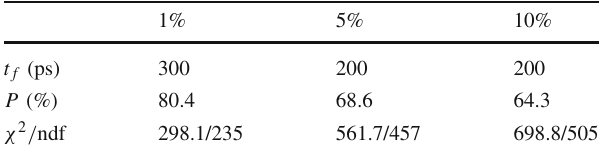
Fig. 12 The timing of the best-fit simulation model compared to that observed in data for the 1% (left), 5% (middle), and 10% (right) WbLS samples. Dark hits were not simulated and have been statistically sub-